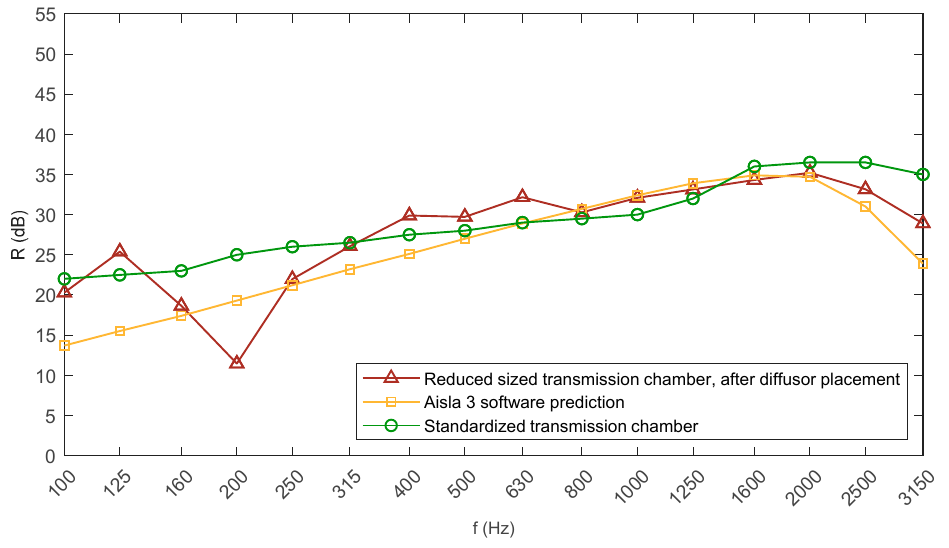
Figure 5. Comparison of the results obtained for a single 13 mm thick plasterboard.